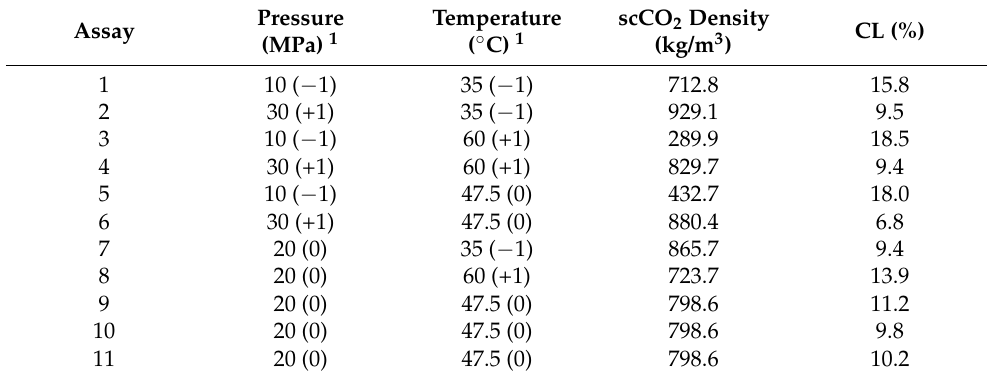
Table 1. Supercritical impregnation experiments and their clove extract loading (CL%) in PC.